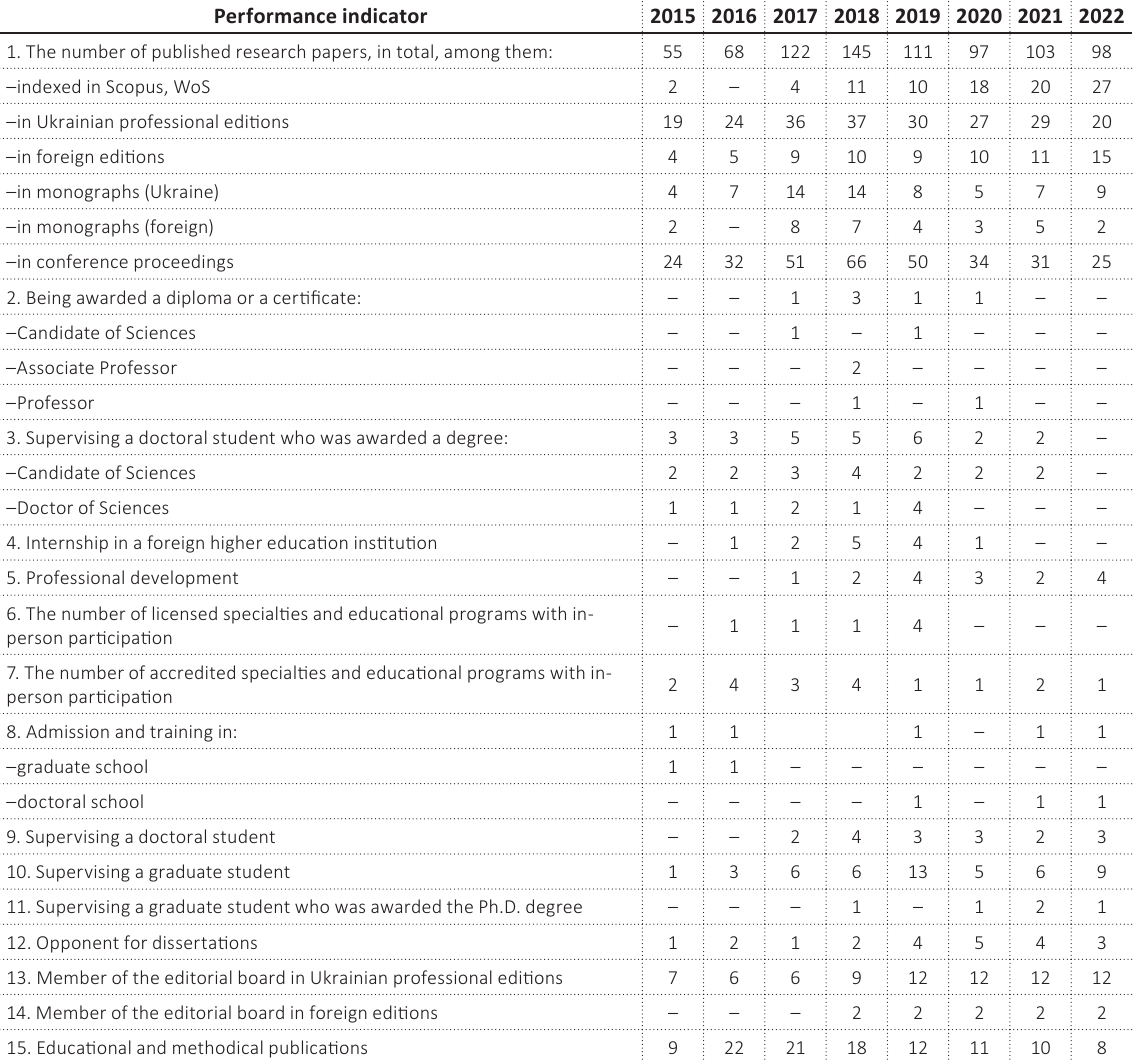
Source: Questionnaire